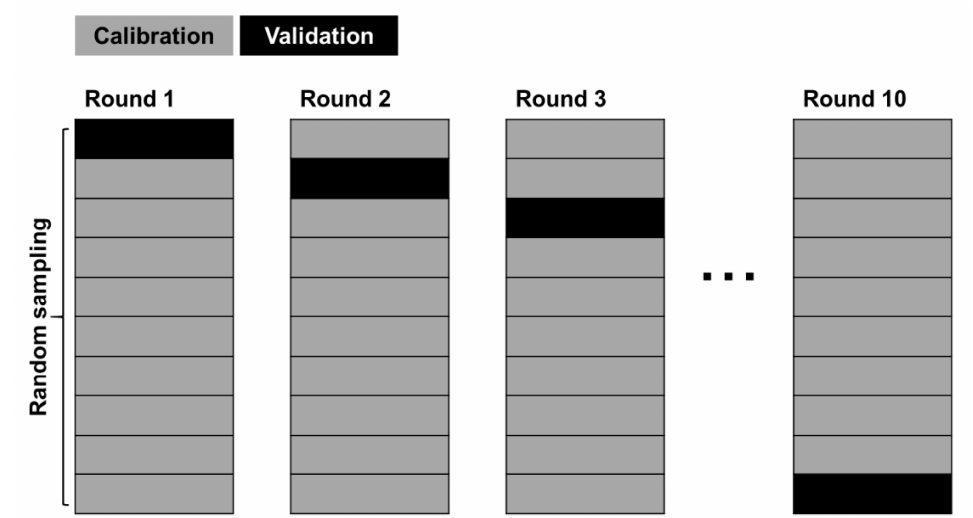
Figure 4. Conceptual diagram of 10-fold calibration/validation with random sampling [42].